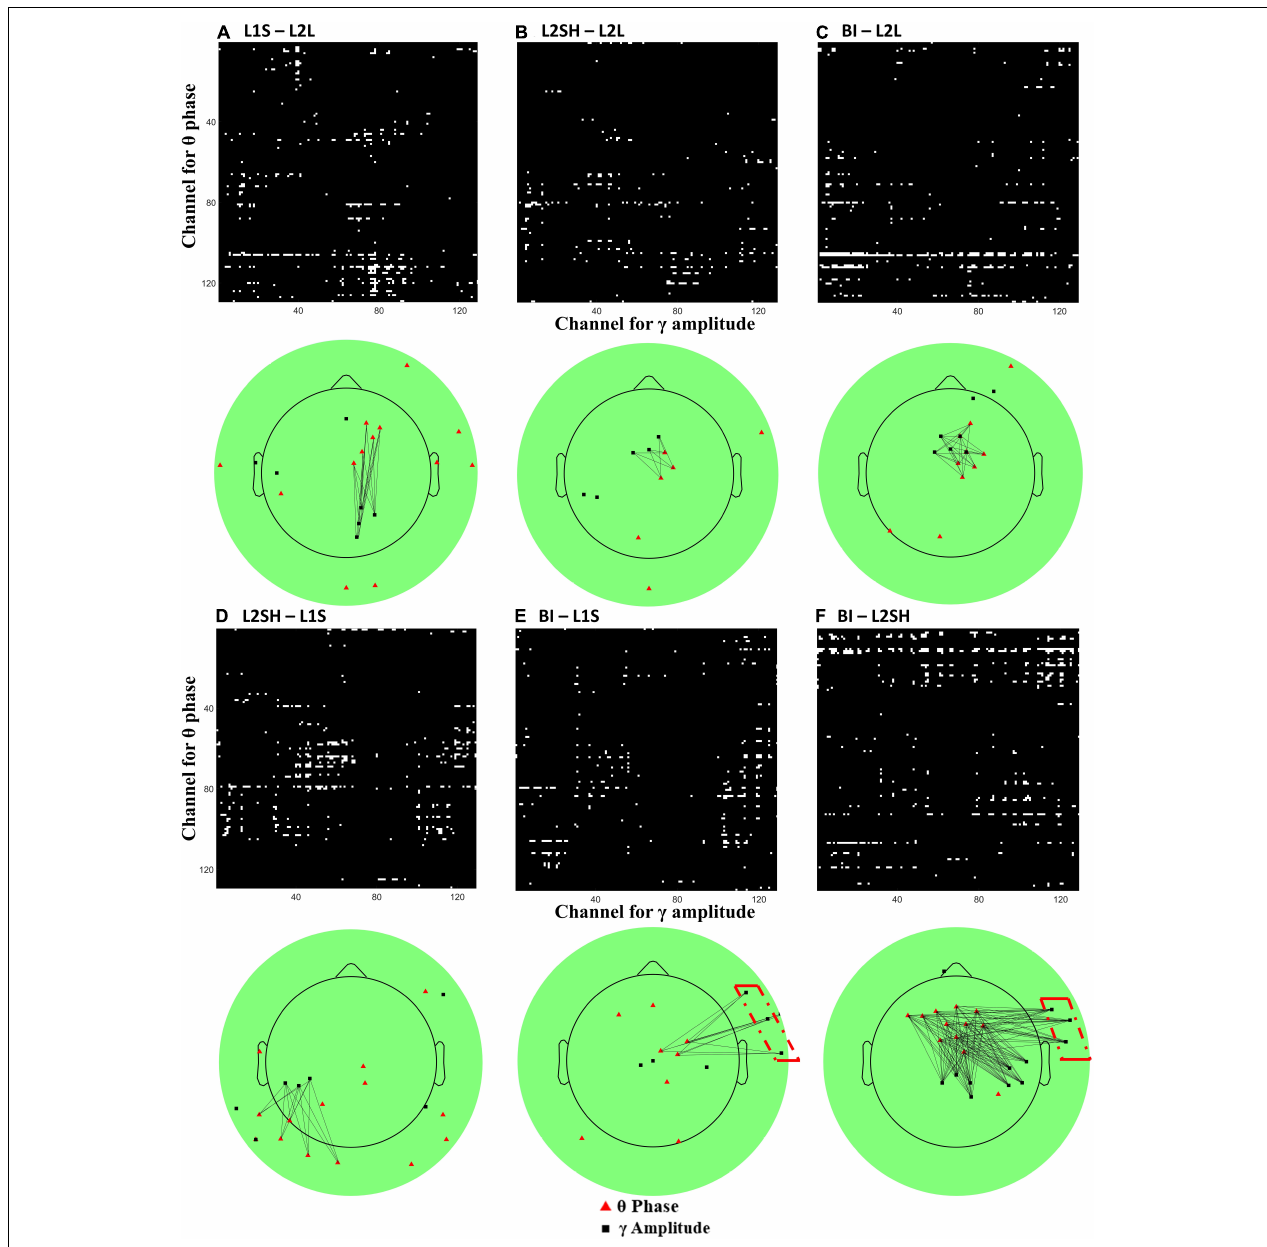
FIGURE 5 | All-to-all theta-gamma coupling (TGC) synchronization map and its topography. (A) L1 speaking minus L2 listening. (B) L2 shadowing minus L2 listening. (C) Backward interpreting minus L2 listening. (D) L2 shadowing minus L1 speaking. (E) Backward interpreting minus L1 speaking. (F) Backward interpreting minus L2 shadowing. On each panel the upper half is channel-to-channel theta ( Y axis) and gamma ( X axis) coupling map, where white pixels represent TGC values surviving a threshold of two standard deviations above the median, and the lower half is the projection of the upper map onto the 128-channel EEG scalp, where the red triangles sit in the position of electrodes for theta activation and the black squares gamma activation. The black lines mark the potential synchronizations between electrodes. Note that only clusters (neighboring electrode numbers > 3) are linked in the plot for illustration purposes. The red dash-dot boxes on (E,F) mark the unique synchronization of BI compared to L1S and